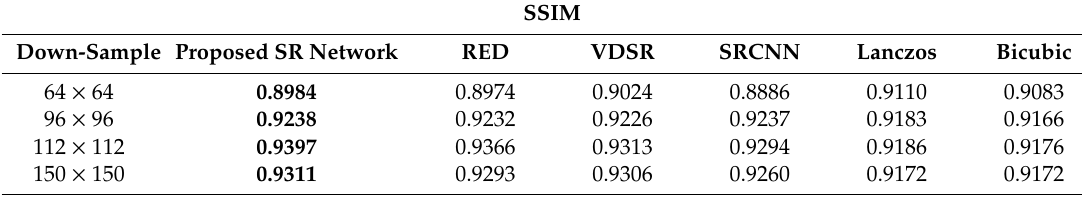
Table 4. Average PSNR and SSIM in di ff erent down-sampled images.